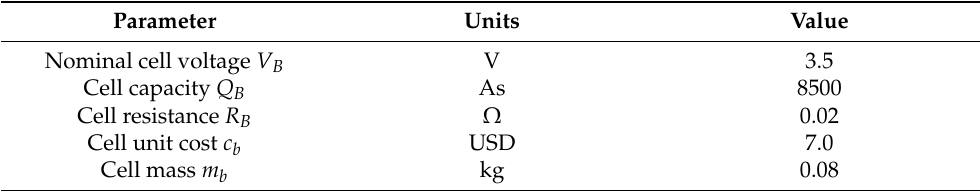
Table 1. Main specifications of the